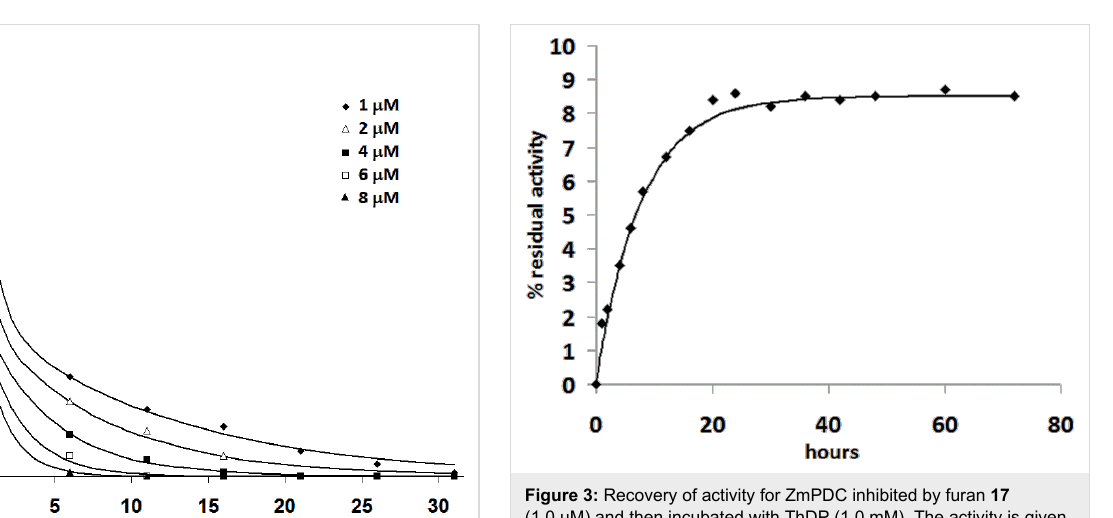
The apparent two-stage inhibition for PDC was reported by